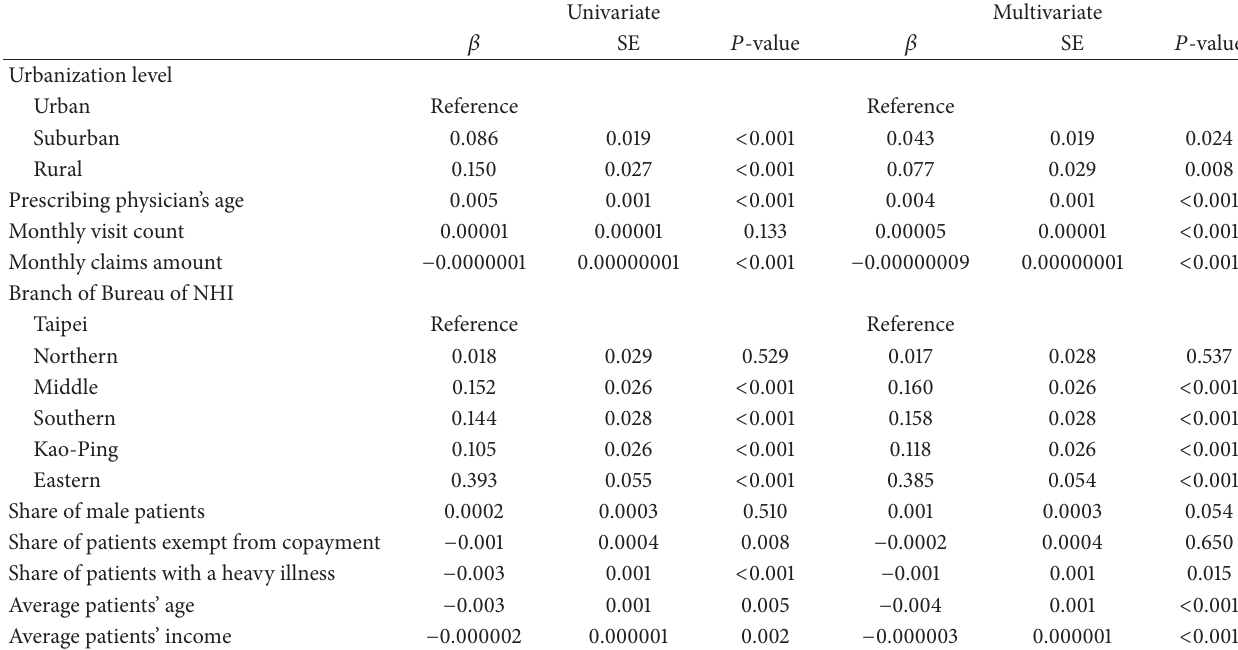
Table 4: Regression model of predicting the generic prescribing ratio of dihydropyridine (DHP) derivatives of a physician clinic with urbanization level and adjusting other